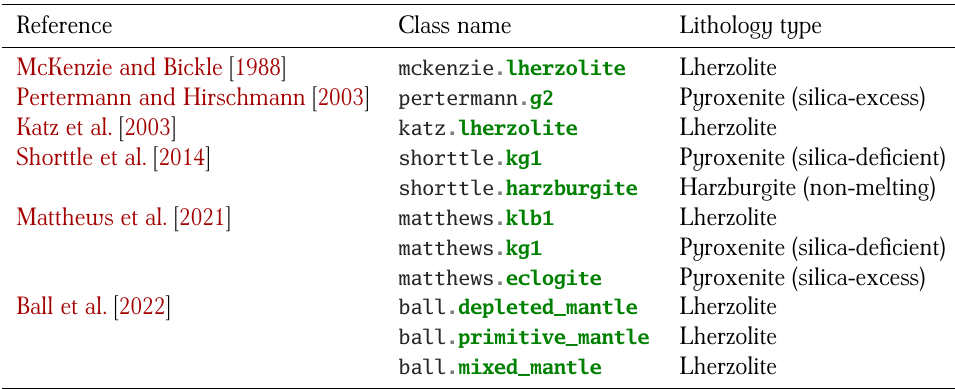
Table 1: The pure lithology melting parameterisations built into pyMelt . See Lambart et al. [2016] for a description of the pyroxenite